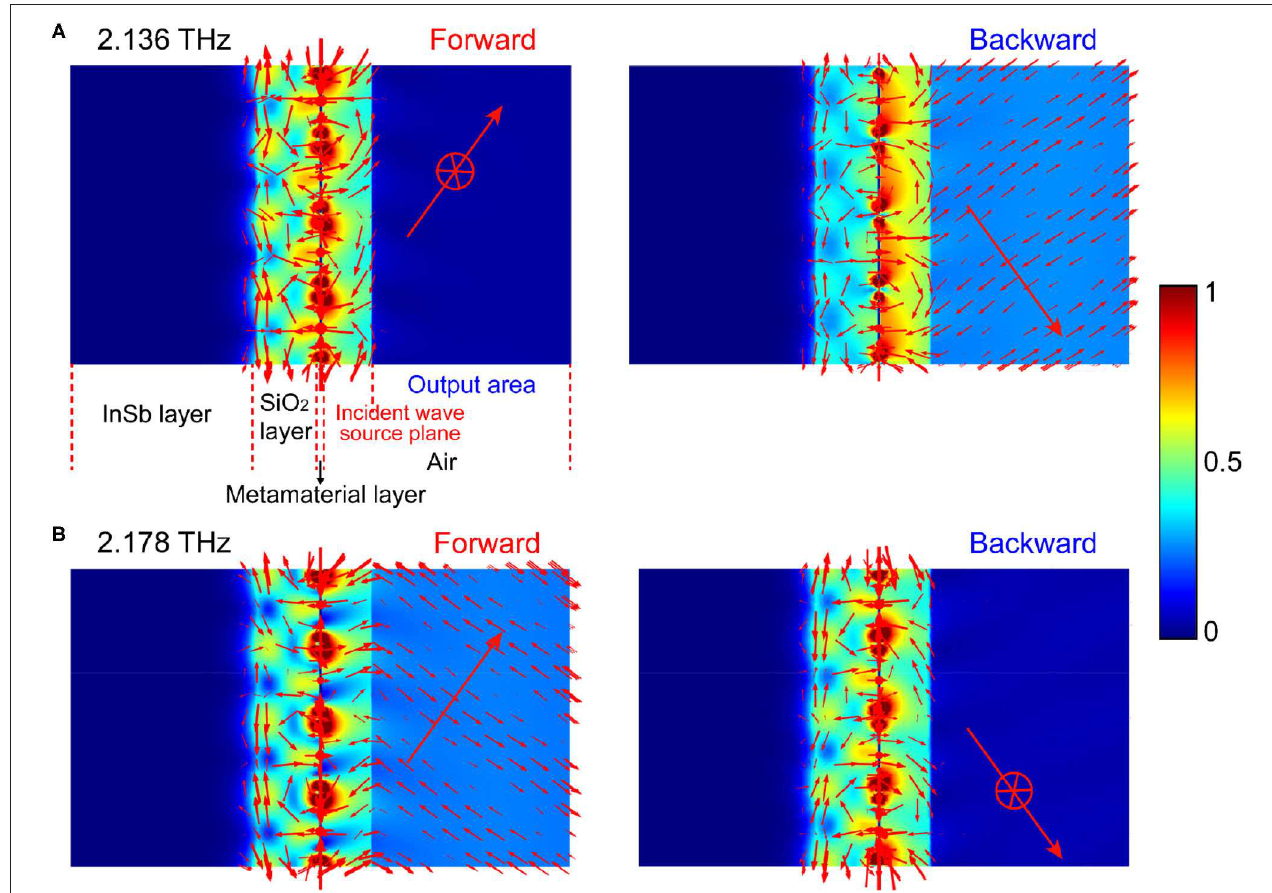
FIGURE 6 | The electric field (color) and the magnetic field (arrows) distributions of the proposed THz optical isolator when α frequencies: f 2.136 THz (A) and f 2.178 THz (B) . THz waves are incident from the source plane to the MO microstructure (i.e., to the left), and then reflected by = = the MO microstructure. The reflected wave finally enters the air on the right side. The left side of the source plane is the total field distribution, including the incident field and the reflected field. The right side of the source plane is the pure reflected field